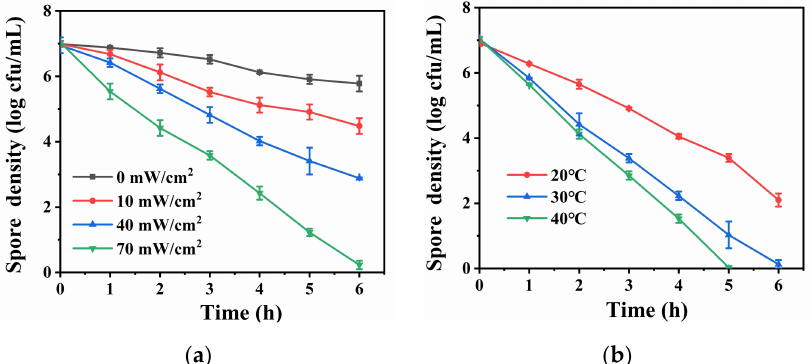
Figure 4. ( a ) Comparison of the efficiency of inactivating bacterial spores under different light inten- sities (The reaction temperature was kept at 30 ◦ C); ( b ) Comparison of the efficiency of inactivating bacterial spores at different temperatures (The light intensity was kept at 70 mM/cm 2